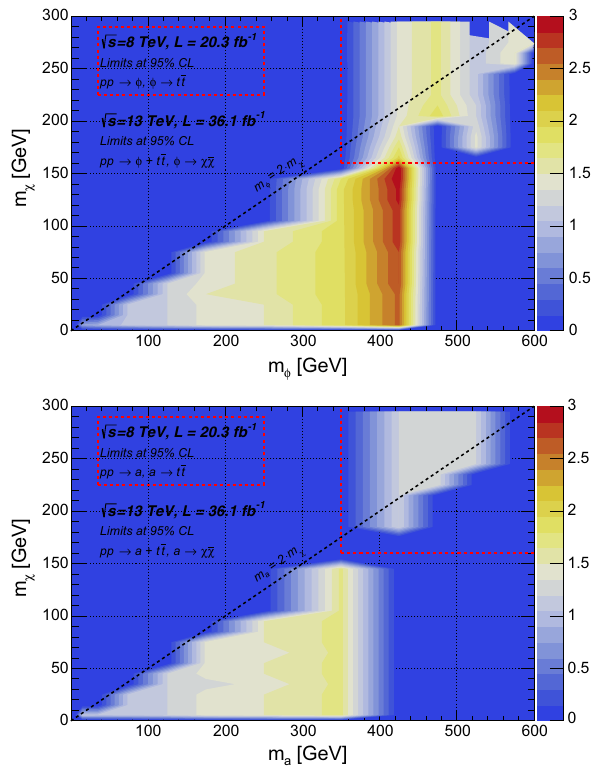
Fig. 3 Exclusion contour for DM simplified models in the ( m φ/ a , m χ ) plane for the scalar (upper) and pseudo-scalar (bottom) scenarios. The contour corresponds to the lowest value of the coupling g = g χ = g v allowed. Results from both t ¯ t resonance and t ¯ t + χ ¯ χ signatures are presented for comparison, while the red dashed lines delimitate the limits set by the t ¯ t resonance signature. The diagonal black dashed lines present the limit in the parameter space where the mediator is heavy enough to decay to a pair of DM